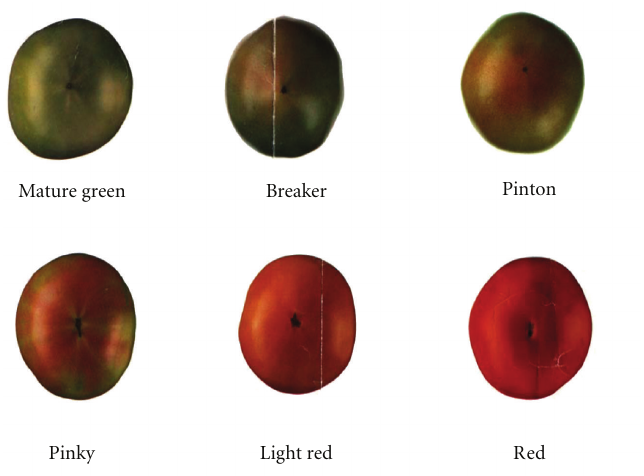
Figure 2: Di ff erent colour stages of mature process in tomato (California Tomato Board, USDA, 1976).